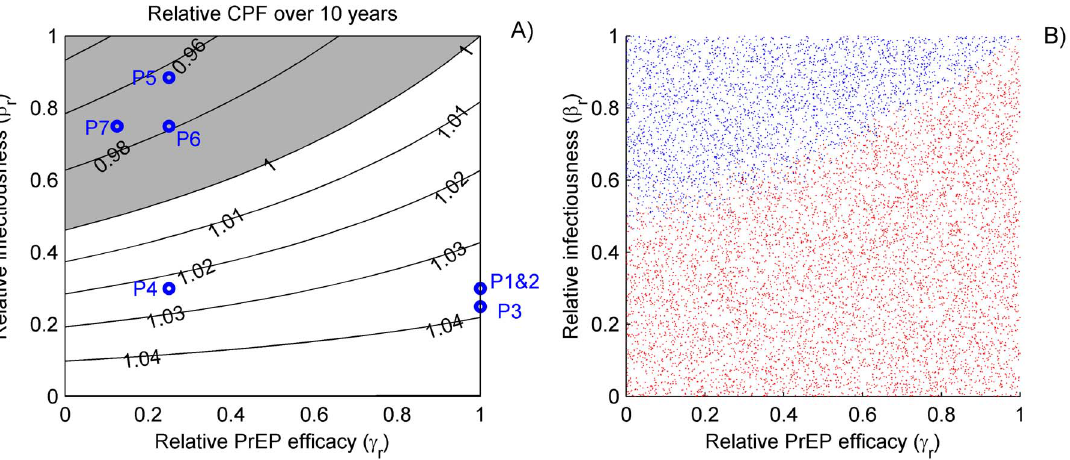
Figure 3. Impact of the relative PrEP efficacy ( c r , 0 – no protection, 1 – equal protection) when exposed to drug-resistant compared to wild type HIV and the relative infectiousness ( b r , 0 – not infectious, 1 – equally infectious) of individuals infected with drug- resistant compared to wild-type HIV on the resistance contribution to the cumulative fraction of infections prevented (CPF) over 10 years. A) Contour plots of the relative CPF with all resistance parameters, except c r and b r , fixed on their baseline values from Table 2 (last column). Values less than one (shaded region) indicate that resistance impacts negatively the estimate of the CPF. Blue dots represent the median value of c r and b r from the parameter sets defined in Table 2; and B) Simulations with positive (red) and negative (blue) resistance contributions using resistance parameters randomly sampled from the ranges in Table 2 (last column).; Relative CPF is calculated as the ratio of the 10-year CPF for scenarios with